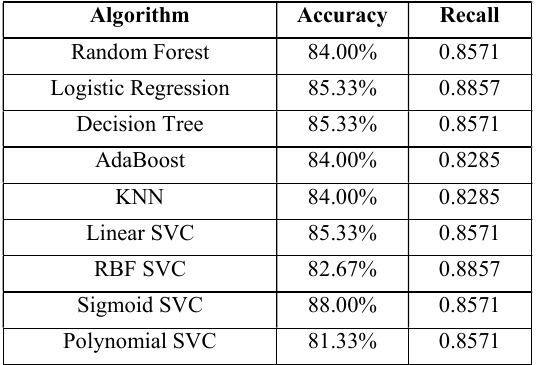
Table 3 : Model Accuracies for Diabetic